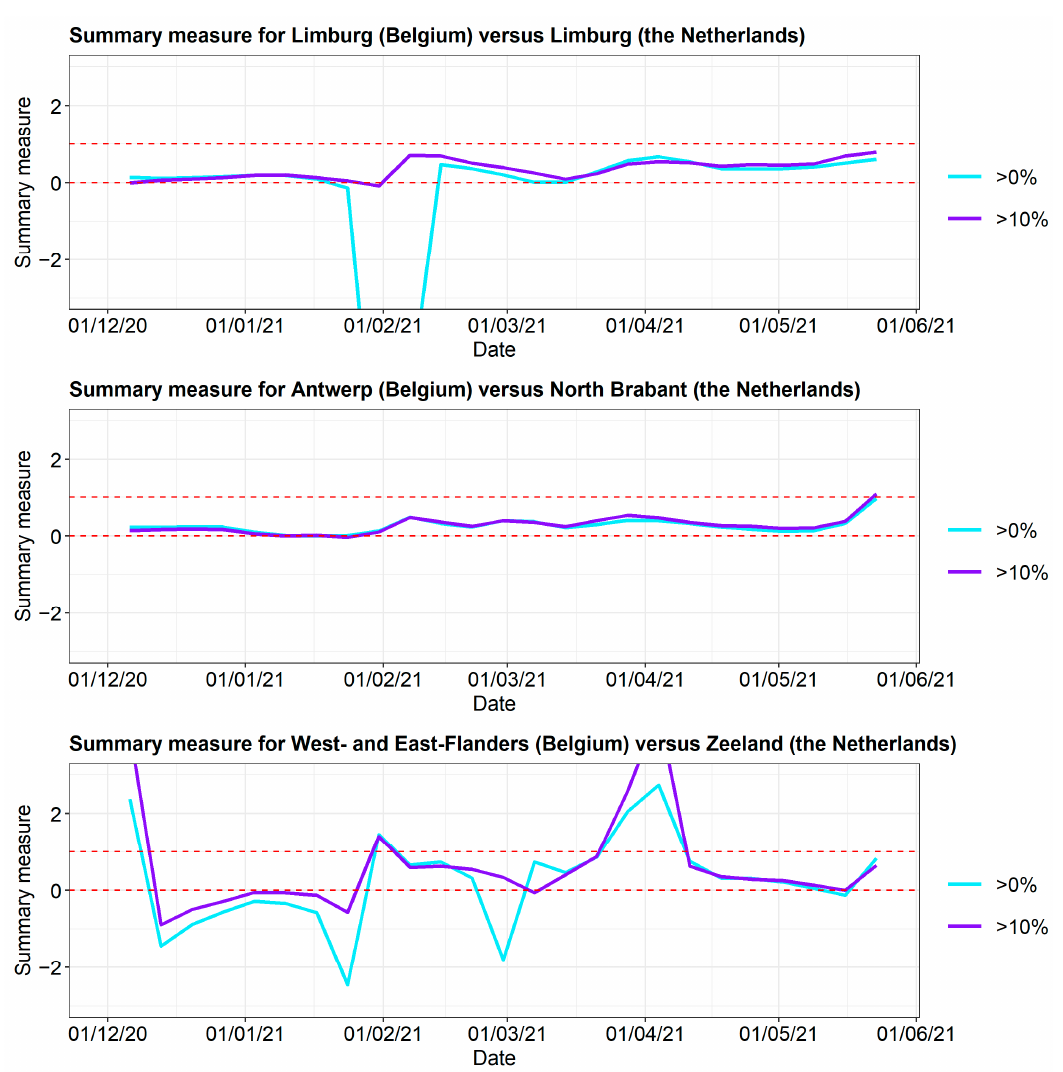
Figure 10. Summary measure of the COVID-19 incidences for 3 provinces along the border with The Netherlands. The red dashed lines represent T = 1 (the incidence in the border area equals the incidence in the Dutch province) and T = 0 (the incidence curve in the border area equals the incidence curve in the rest of the Flemish province). When the incidence curve in the border area lies between the incidence curves of the rest of the Flemish province and the Dutch province, T lies in the unit interval. When the behavior of the border region does not interpolate between its neighbors, T lies outside the unit interval.